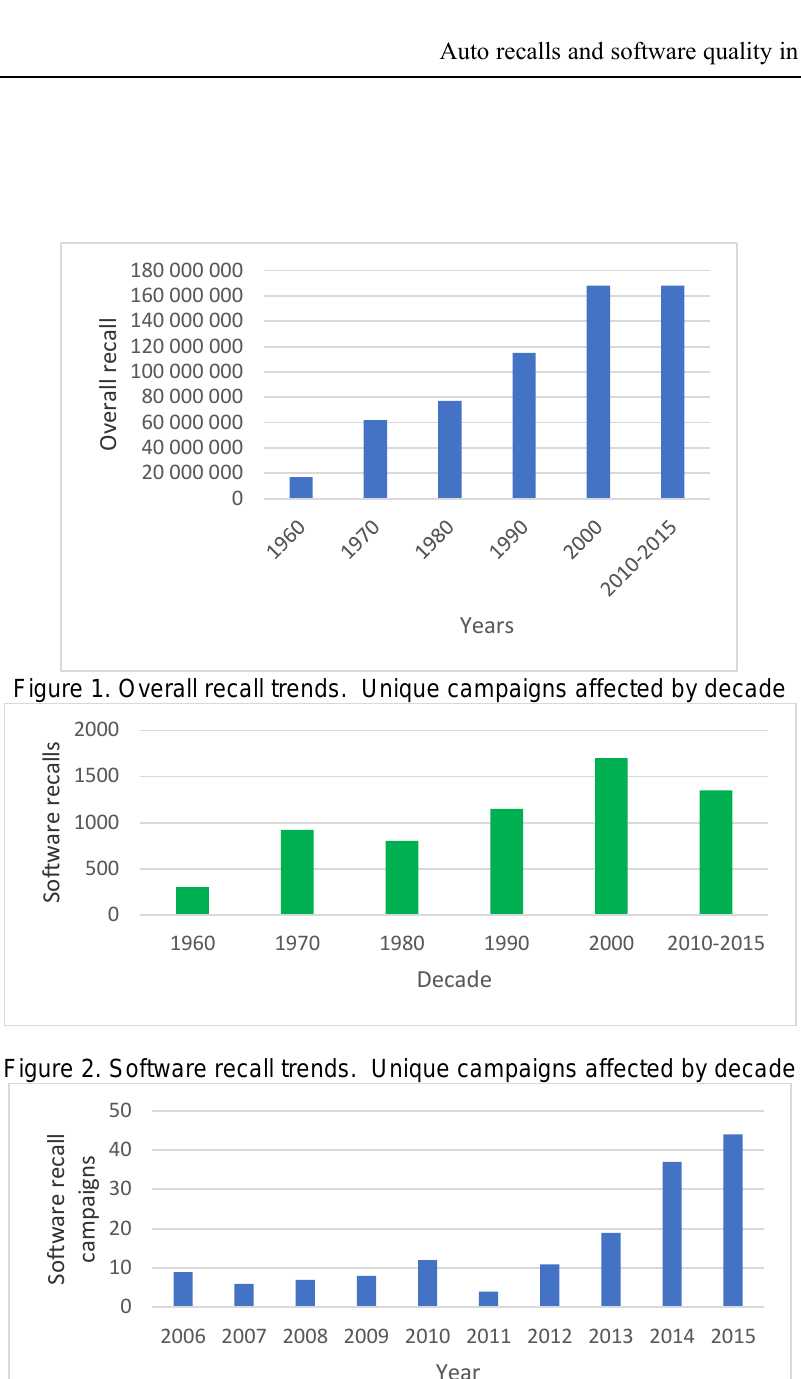
Figure 3 Summary of software recalls by year (2006-2015) – unique